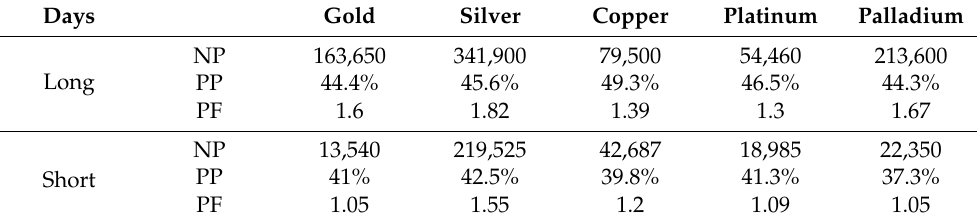
Table 4. Linear regression trading results of long/short strategies.